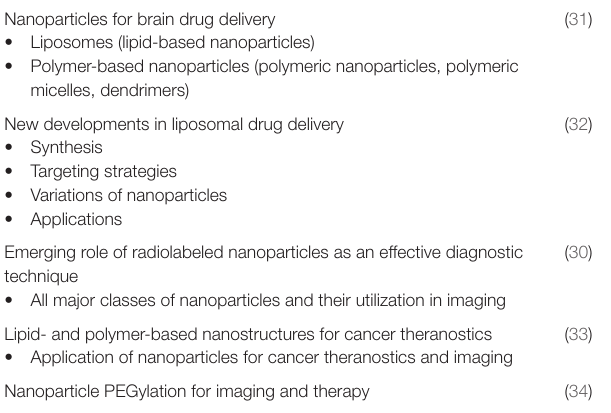
TABLe 2 | Reviews regarding lipid-based